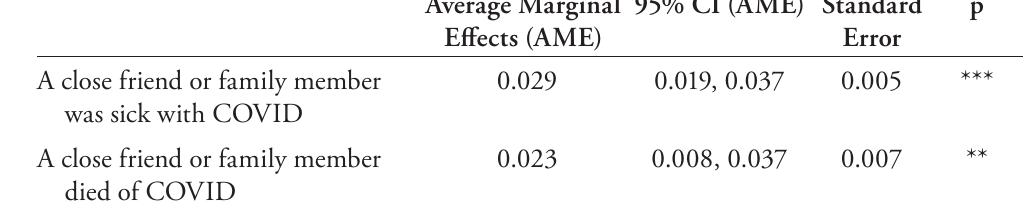
Table 2. Results of the Logistic Regression for Major Depressive Disorder (MDD) ( continued